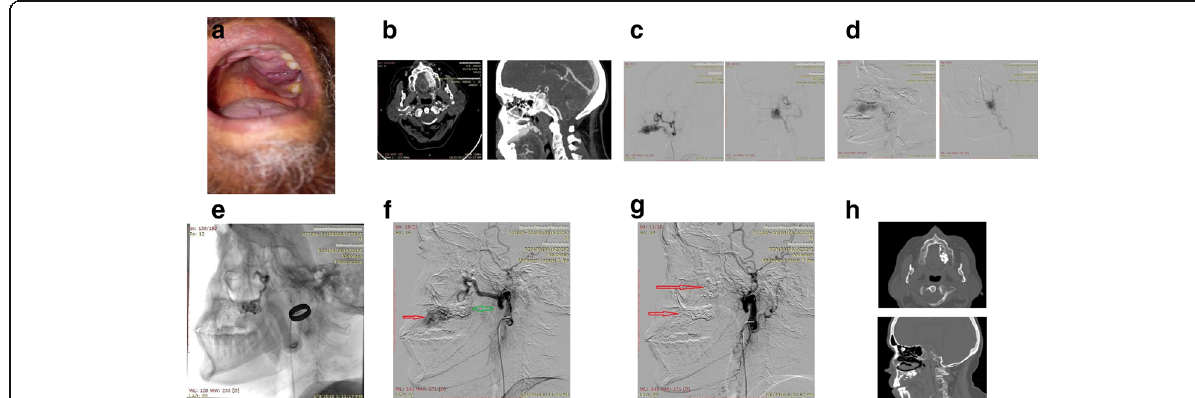
Fig. 1 Male patient presented by a pulsating left-sided upper oral cavity lesion. a A real photo showing bulging bluish lesion in the left side of the oral cavity. b Axial and sagittal (MIP image) sections of CTA revealing a left-sided buccal AVM. c DSA showing the palatine AVM using the macro-catheter in lateral and AP projections. d DSA showing the palatine AVM using the micro-catheter in lateral and AP projections. e DSA showing the glue material within the AVM which is apparently occluded at post-embolization angiogram super-selectively via the facial artery. f Another DSA image showed a reisdual active small component (red arrow) nearby the occluded component (green arrow). g The last post- embolization angiogram showing total obliteration of both components of the AVM after superselective catheterization of the feeding branch of the facial artery. h Non-contrast CT axial and sagittal images showing the retained glue material within the nidus of the AVM after